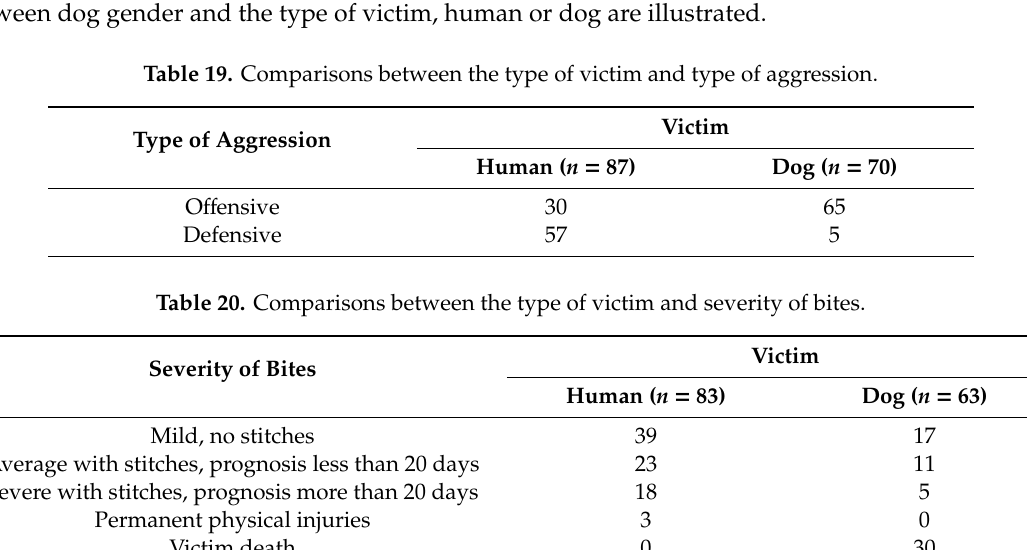
Average with stitches, prognosis less than 20 days Severe with stitches, prognosis more than 20 days